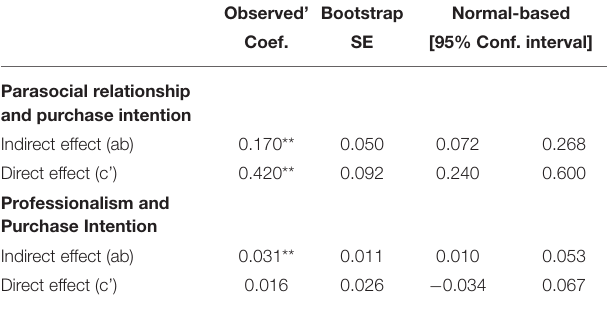
TABLE 3 | Regression analysis of estimated main effects and moderating effects. TABLE 4 | Bootstrap analysis of trust mediation effect.